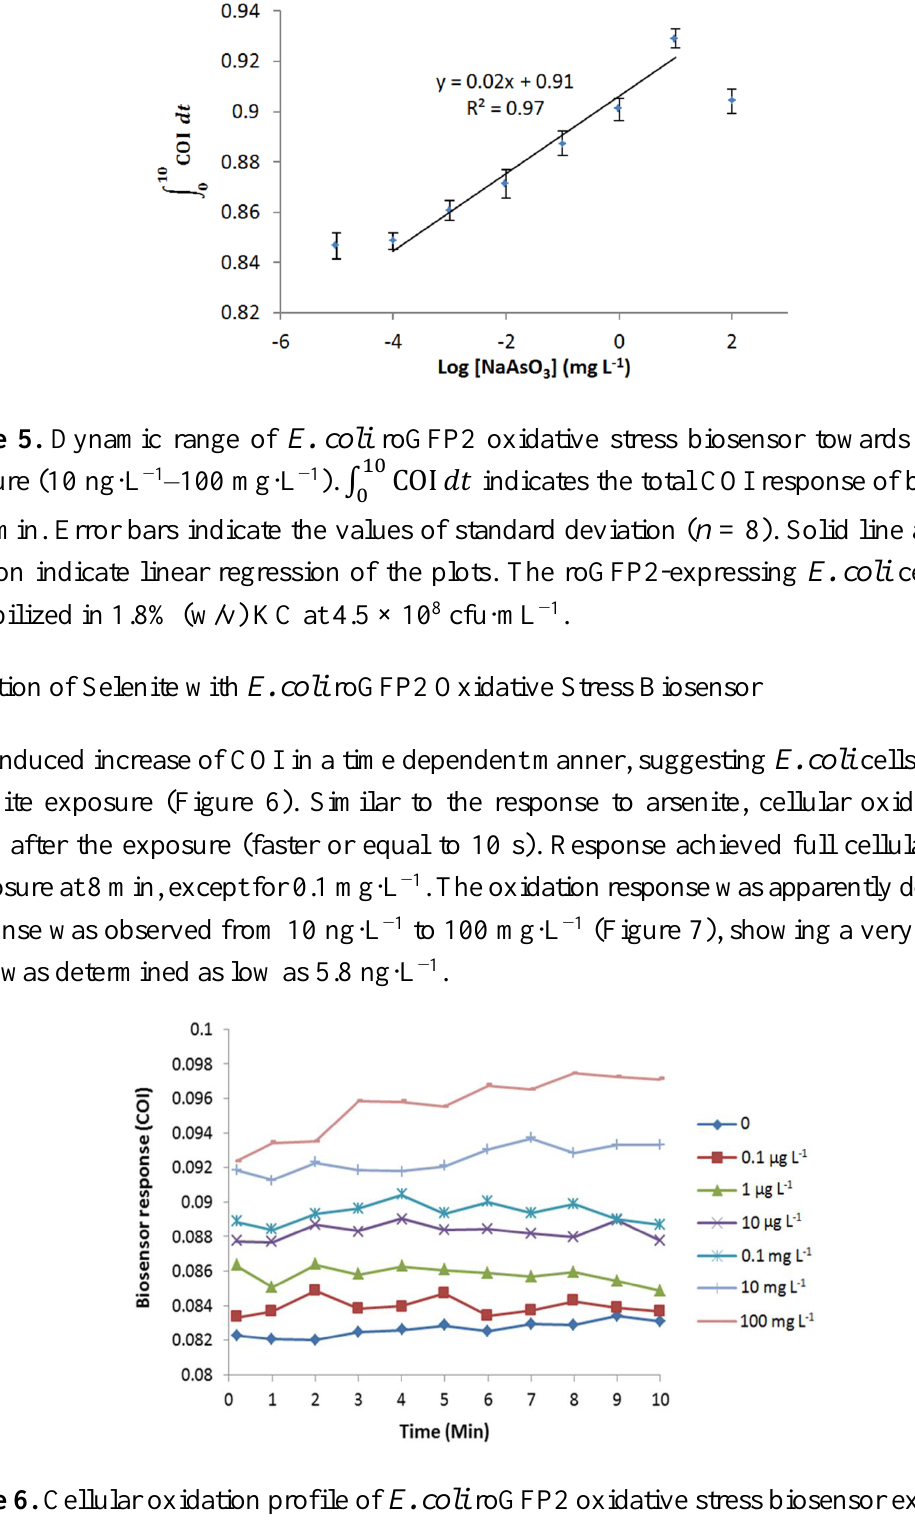
Figure 6. Cellular oxidation profile of E. coli roGFP2 oxidative stress biosensor exposed